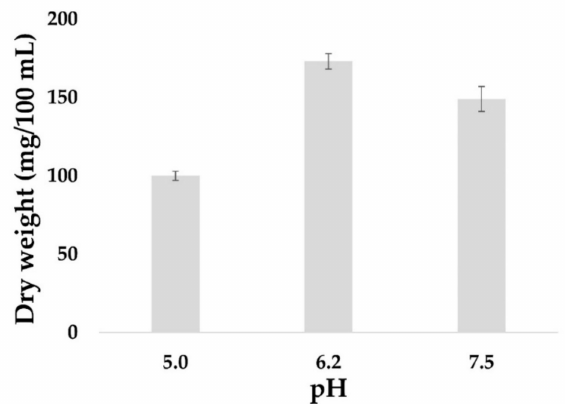
Figure 3. E ff ect of pH on Inonotus obliquus biomass. I. obliquus was grown in a liquid medium of a yeast malt broth medium (YMB) at 28 ◦ C for eight days. The pH of the medium was adjusted by adding HCl or NaOH to obtain three final pH values of 5, 6.2 and 7.5. At day eight, I. obliquus cells were collected, filtered and dried at 70 ◦ C overnight. Results represent the average ( ± error bars) dry weight (mg) of three biological repetitions per